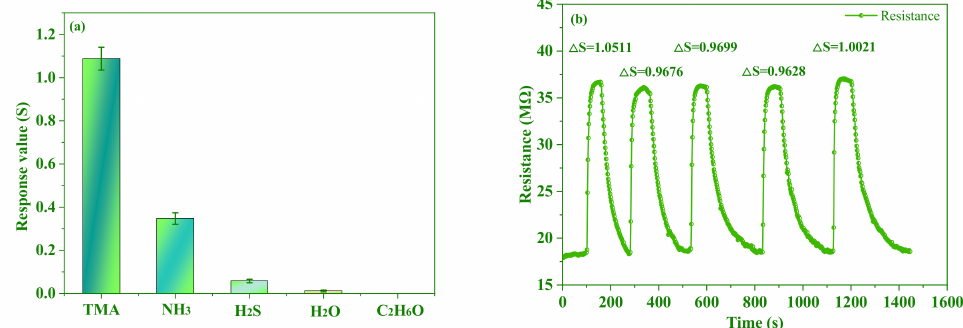
Figure 5. Sensor response of the PANI/AgNWs/silk composite nanofibers to 100 µ g/L of different gases ( a ) and the response and recovery curves and the response value of the sensor towards 100 µ g/L TMA for five cycles ( b